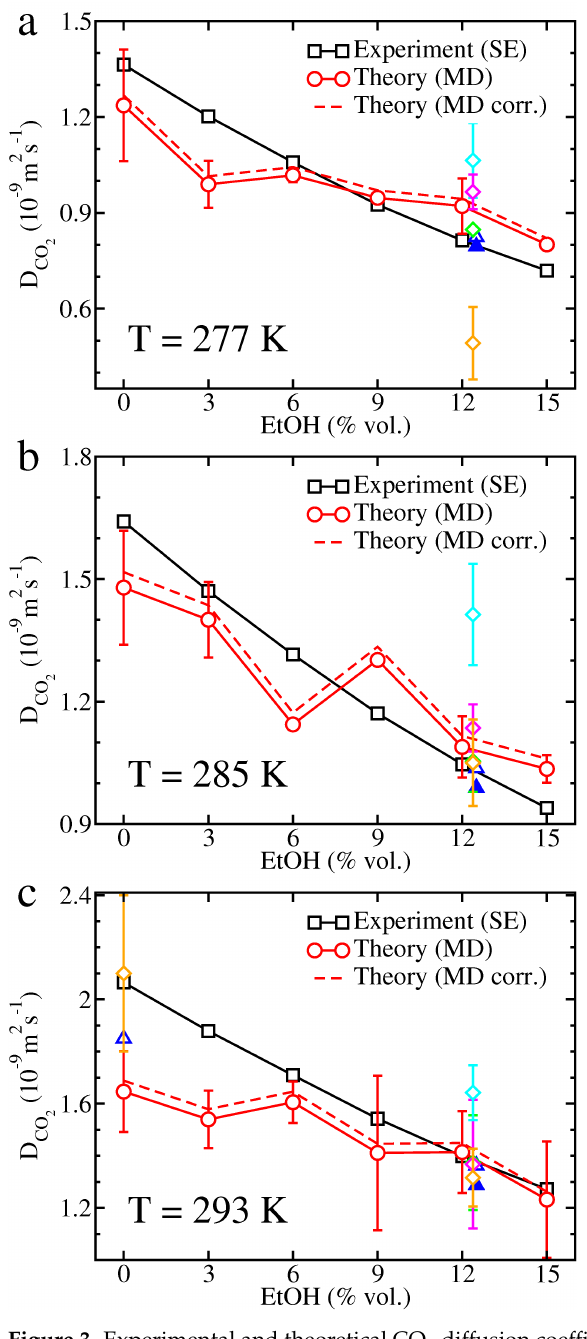
Figure 3. Experimental and theoretical CO 2 diffusion coefficients in carbonated hydroalcoholic solu- tions at ( a ) T = 277 K, ( b ) T = 285 K, and ( c ) T = 293 K. Experimental values (black squares) derived from the Stokes-Einstein (SE) relation and theoretical values deduced from molecular dynamics (MD) simulations (red circles) are reported together with theoretical diffusion coefficients corrected for system-size dependence (red dashed curve). Data from the literature are also indicated: MD simulations on carbonated hydroalcoholic solutions (ethanol (EtOH) at 12.4% vol.) where water is described by the OPC (Optimal Point Charge) model (green diamond) [34], TIP4P/2005 (Transferable Intermolecular Potential with 4 Points/2005) model (magenta diamond) [34], SPC/E (Extended Sim- ple Point Charge) model (orange diamond) [33,42], and TIP5P (Transferable Intermolecular Potential with 5 Points) model (cyan diamond) [33]; 13 C nuclear magnetic resonance (NMR) measurements on carbonated hydroalcoholic mixtures [33] or fizzy water [30] (blue open triangles) and brut-labeled Champagnes (blue closed triangles)